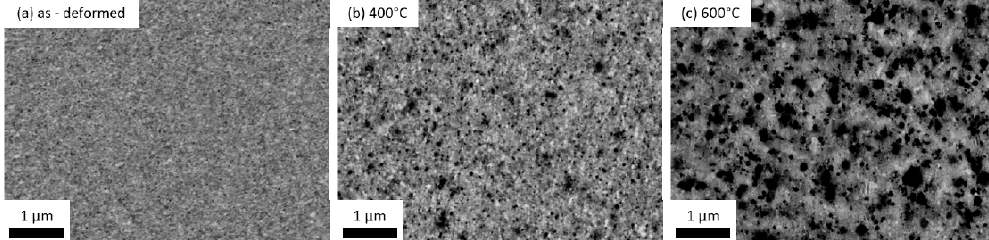
Figure 6. Micrographs of Cu 55 Co 45 in three different microstructural states in tangential view, as-deformed ( a ) and annealed for 1 h at 400 °C ( b ) and 600 °C ( c ).